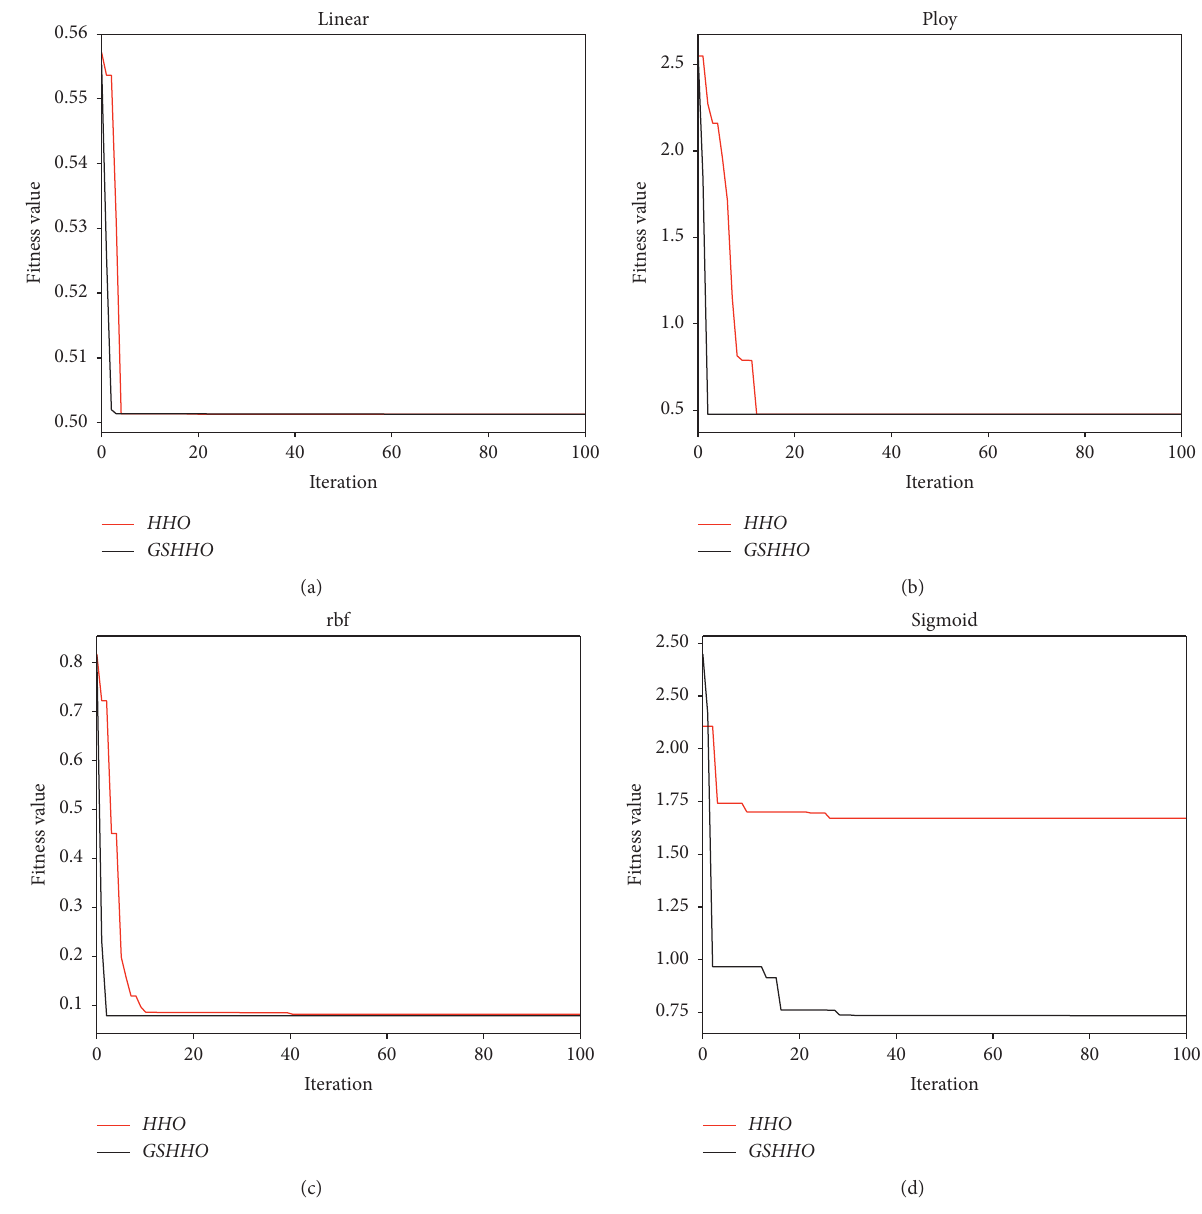
Figure 11: Convergence curves of error functions under four different LSSVM models. Table 6: Quantitative indicators under different soft-sensor Table 7: Parameter values found by the models.